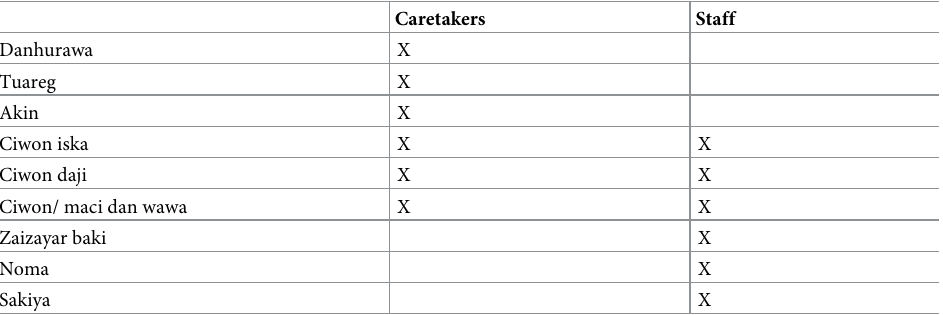
Table 1. Names used by caretakers and Noma Children’s Hospital staff (medical, paramedical and program man- agement staff) to describe noma.